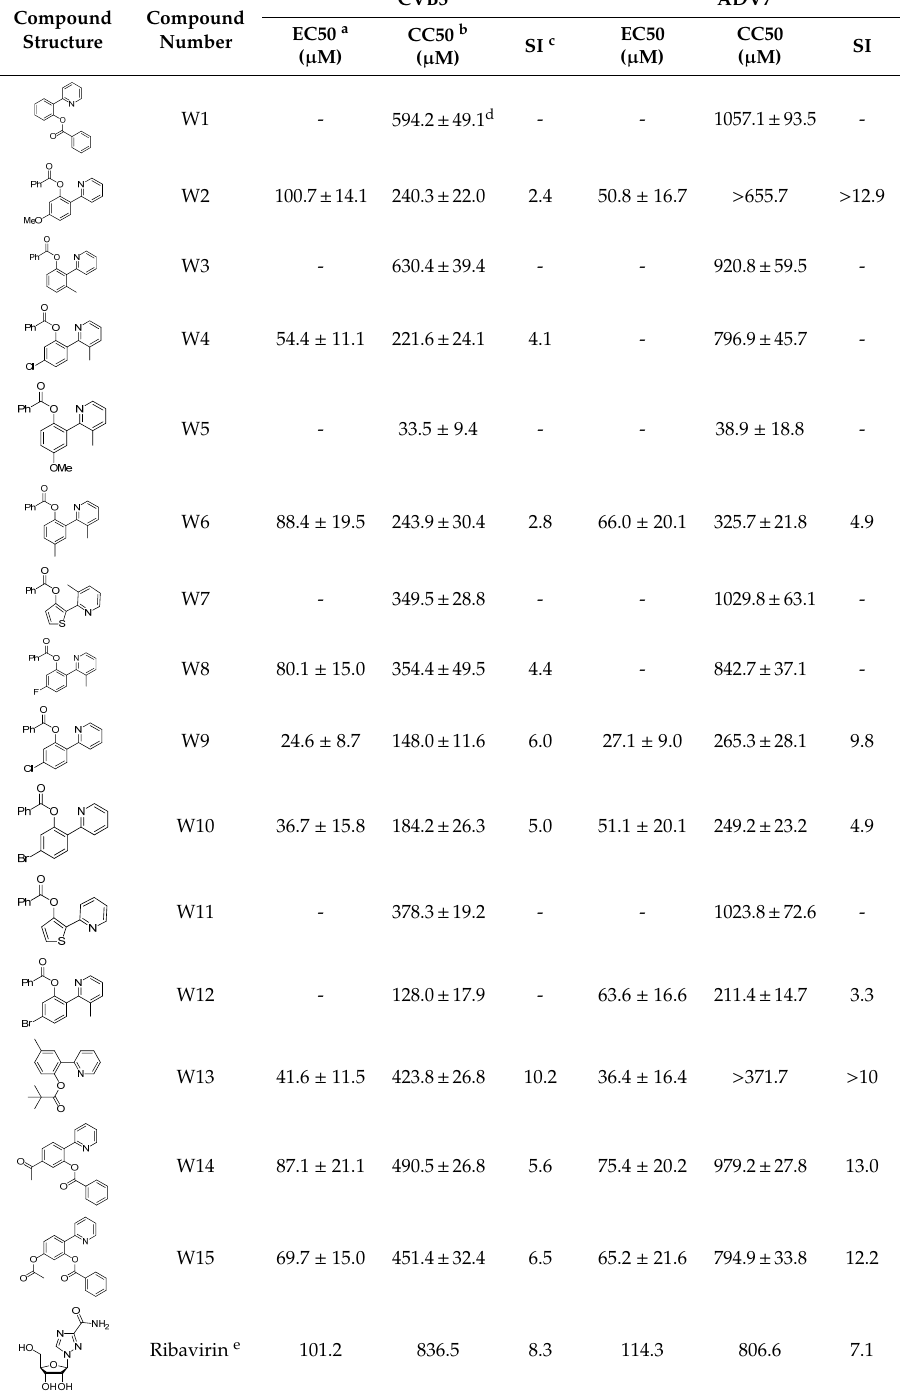
Table 1. Cytotoxicity and antiviral activity of novel 2-benzoxyl-phenylpyridine derivatives against Coxsackievirus B3 (CVB3) and adenovirus type 7 (ADV7). Compound Structure